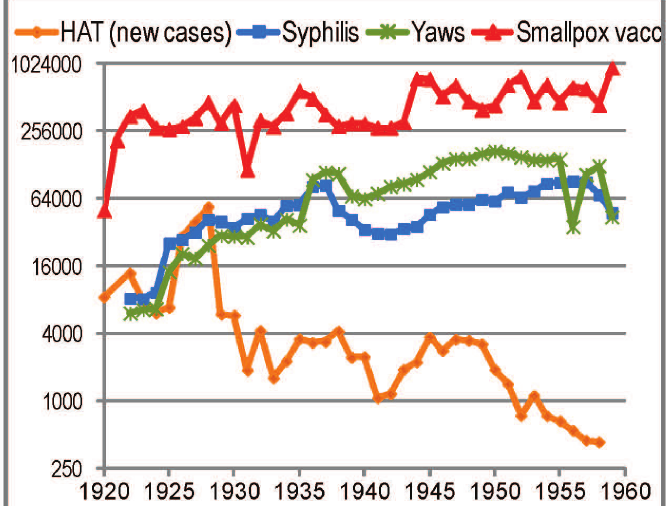
Figure 2. Reported annual numbers of treatments against human African trypanosomiasis (HAT) (only newly diagnosed cases), syphilis and yaws, and of smallpox vaccinations in French-administrated Cameroon, in the period 1920–1960. The references are listed in